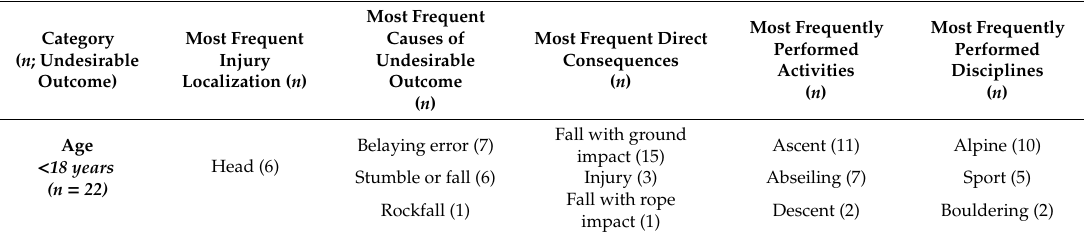
Table A1. Risk factor-dependent presentation of main injury localization, causes, direct consequences, performed activity and discipline leading to undesirable outcome (severe or fatal